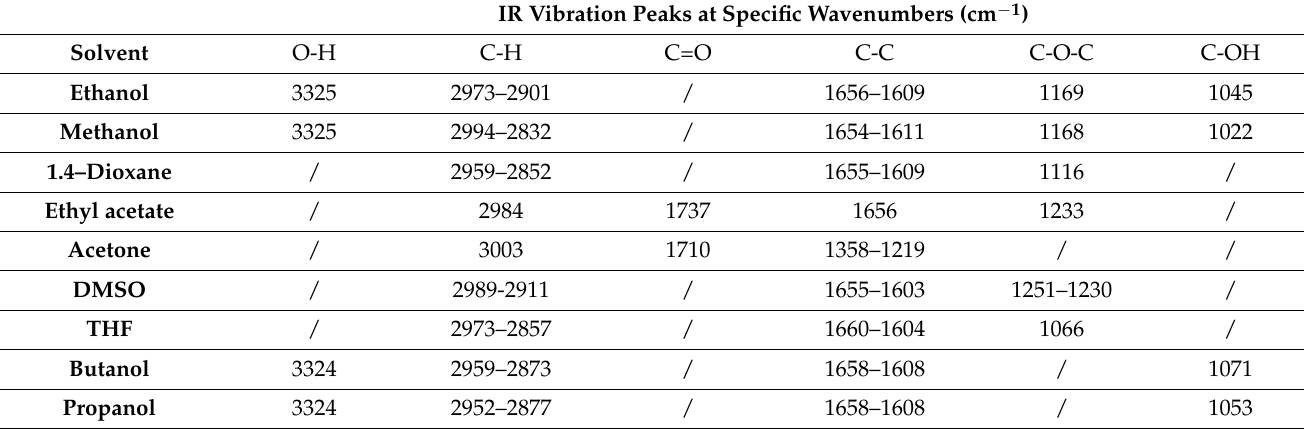
Table 3. IR spectra data (cm − 1 ) of luteolin in presence of the different solvent studied in this work. IR Vibration Peaks at Specific Wavenumbers (cm − 1